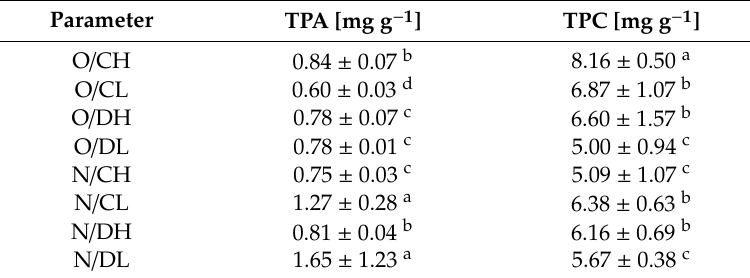
Table 4. Total phenolic acids and total phenolic compounds in GB.